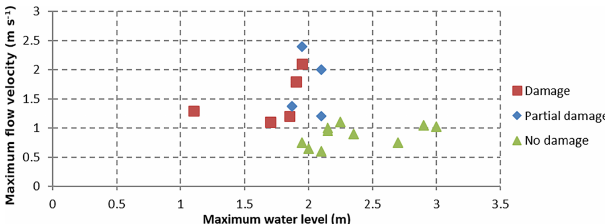
Figure 1. Damage criteria of the aquaculture raft based on the dam- age data from Kii Peninsula, western Japan, from the 1960 Chilean tsunami (Adapted from Nagano et al.,